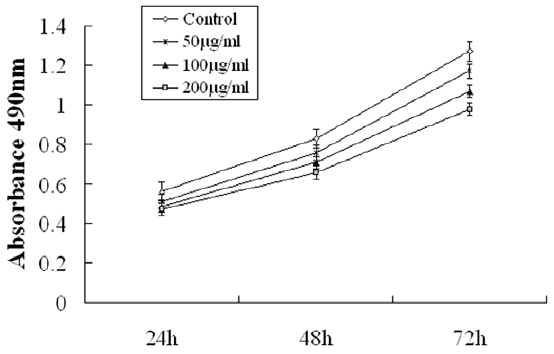
Figure 1. Effect of fucoidan on the growth of normal mouse fibroblasts. The effect of fucoidan on the proliferation of normal mouse fibroblasts (L929 cells) was measured by MTT assay. The cells viability of each fucoidan treatment group(50,100 and 200 m g/ml) was not statistically significant, compared with that of untreated controls ( P . 0.05). Data are shown as mean 6 S.D. Fucoidan did not affect the viability of normal mouse fibroblasts.